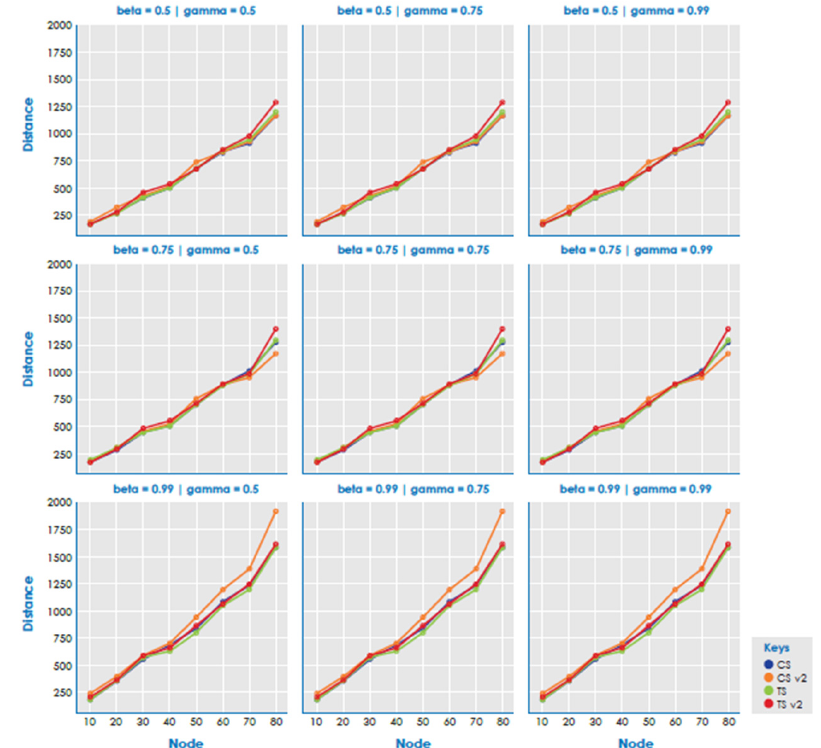
Figure 1. Total distance by methods. α = 0.5 and supermarket = 60%.